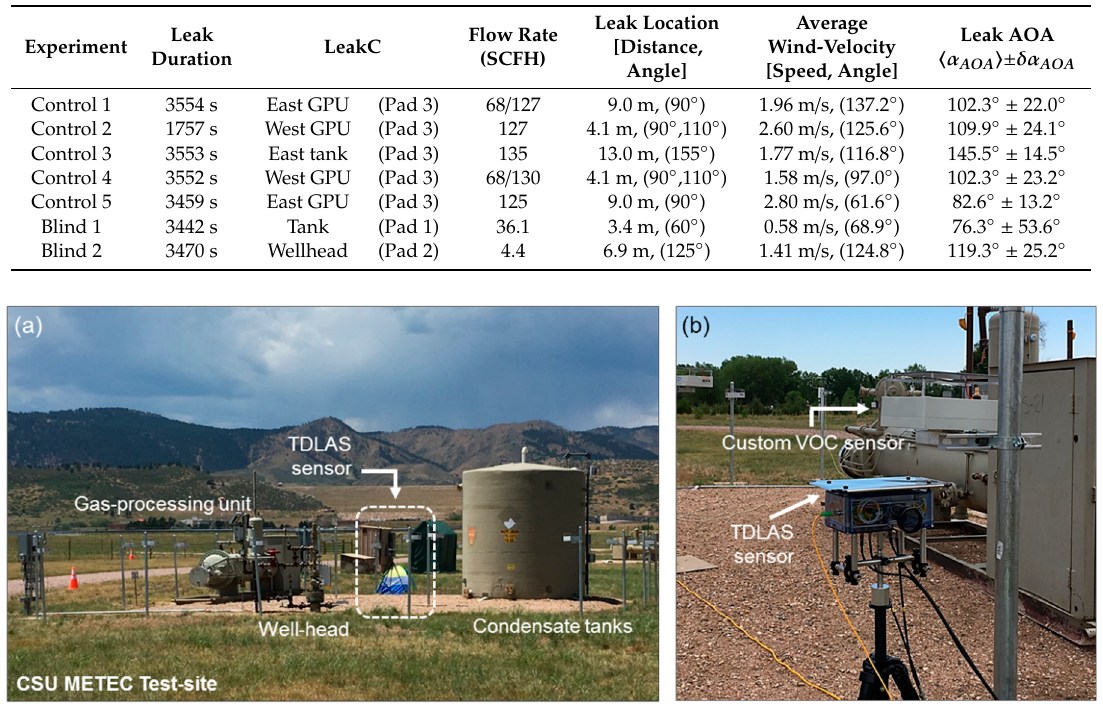
Figure 4. ( a ) Field deployment of the portable TDLAS sensor unit at the CSU METEC test-site. The site layouts typically include some combination of wellheads (or ‘trees’), gas-processing units (GPUs), and condensate tanks, all of which are possible sources from which leaks emanate. For this sample site layout (enumerated as Pad 1 in Table 1), the placement of the optical TDLAS sensor is shown in the white box. ( b ) Close-up of the optical sensor shown in ( a ). The TDLAS sensor is placed in close proximity to a customized metal oxide (MOX) sensor for accuracy benchmarking. The associated control and power units for the sensor are housed nearby the sensor assembly. Table 1. Summary of leak experiments at the METEC facility, with calculated leak angle-of-arrival (AOA) (0° corresponds to North). A total of 6.3 h of leaks from 3 well pads are performed, comprising of 5 control leaks of large magnitude (68 SCFH and above) and 2 blind leaks of smaller magnitude. Control experiments 1 and 4 are split into two flow rates of equal duration, and the two leak location angles in Controls 2 and 4 indicate simultaneous dual-leak points during the experiment.